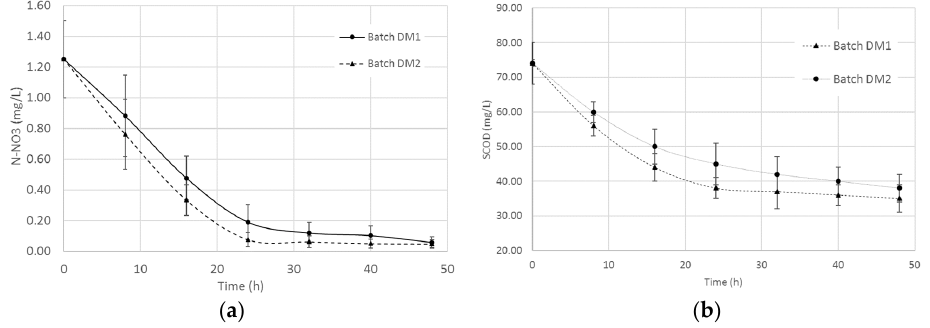
Figure 5. Effect of denitrification of mixed liquor inoculated with R. capsulatus grown in aerobic ‐ dark (batch DM1) and anaerobic ‐ light (batch DM2) on nitrate ( a ) and SCOD ( b ) concentration.